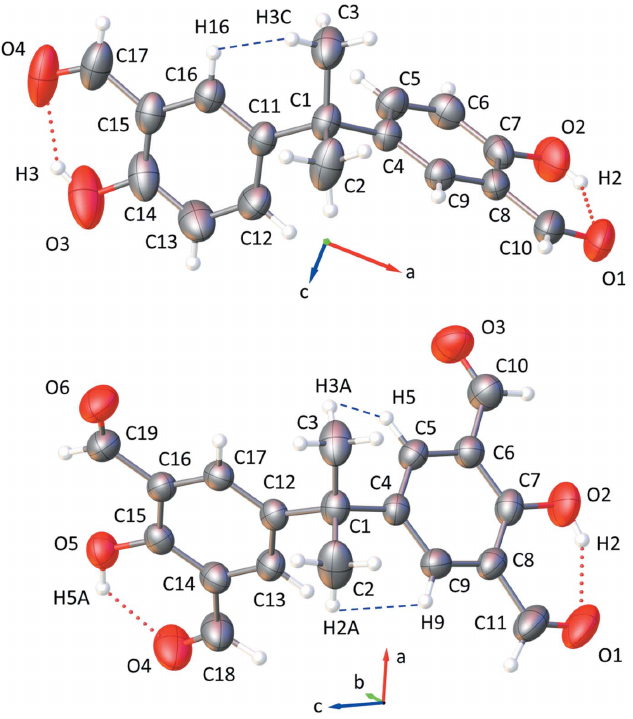
Figure 1 Molecular conformation and atom-numbering scheme for molecules ( 1 ) (top) and ( 2 ) (bottom). Non-hydrogen atoms are shown with 50% probability displacement